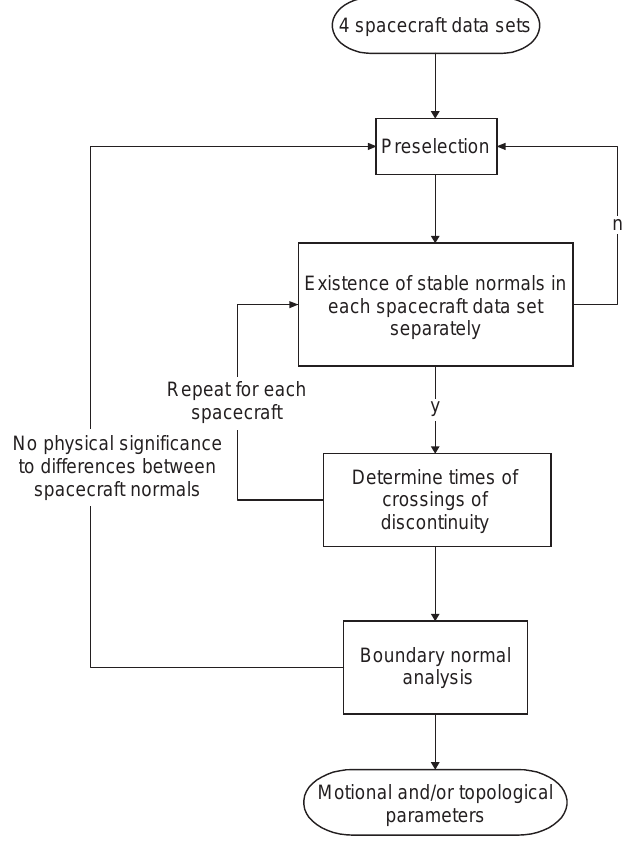
Fig. 1. Conceptual flow chart for the boundary analysis, taken from Dunlop and